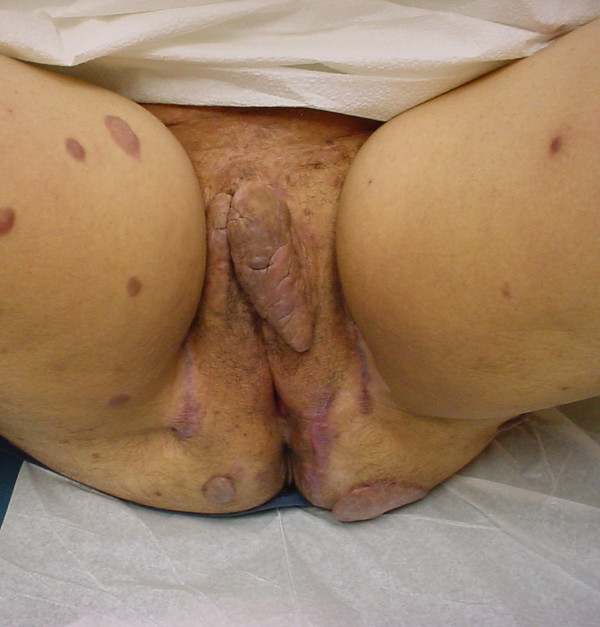
Three-month follow-up appearance after surgical excision and radiotherapy.